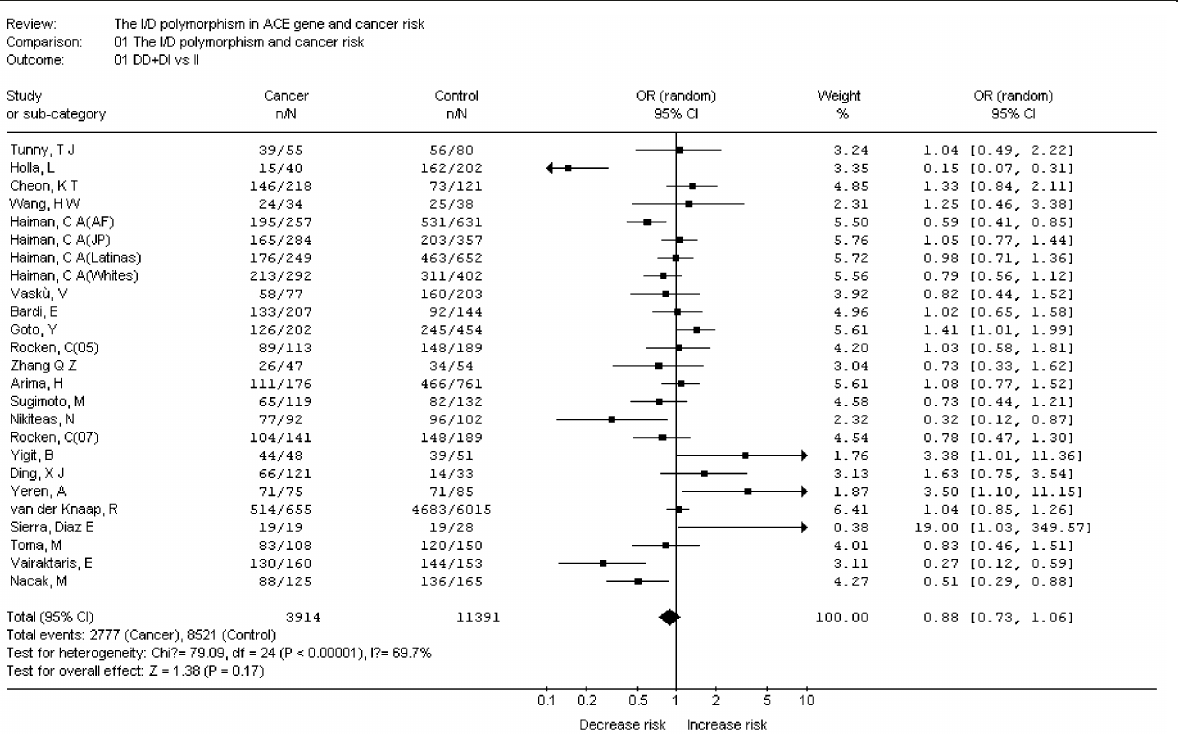
Figure 2 Meta-analysis with a random-effects model for the association between cancer risk and the ACE I/D polymorphism (DD+DI vs II) .